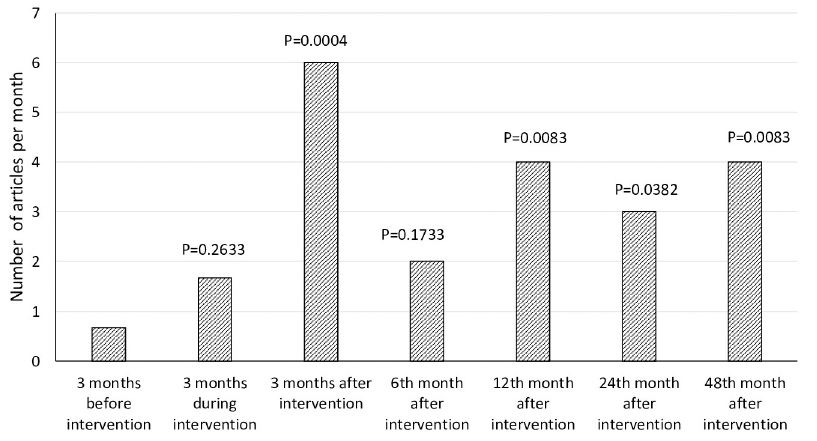
Fig 2. Average number of relevant articles before, during and after the interventions in Changzhi, China.